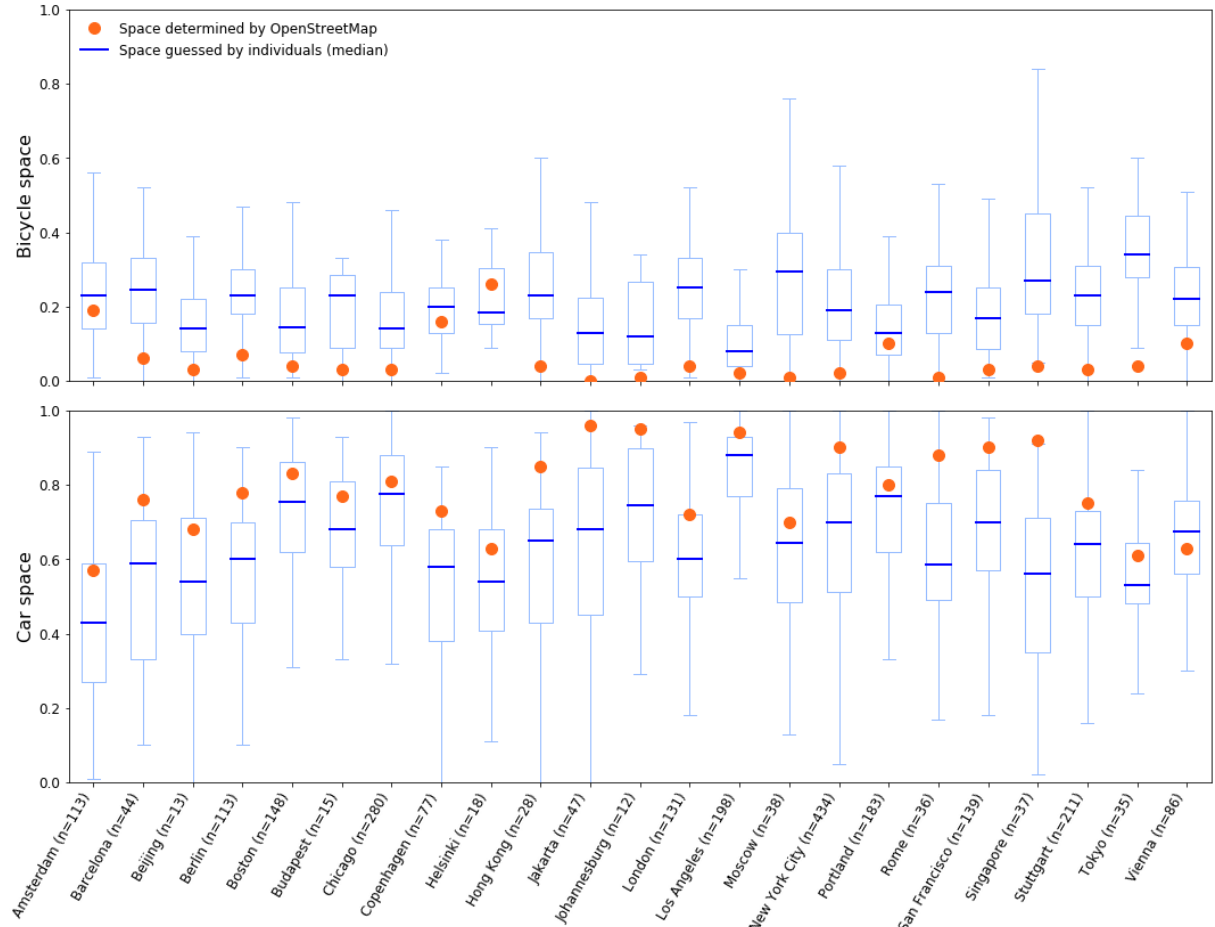
Figure 6. Guesses collected show that people consistently overestimate the space allocated for bicycles (top) and under- estimate the space allocated for cars